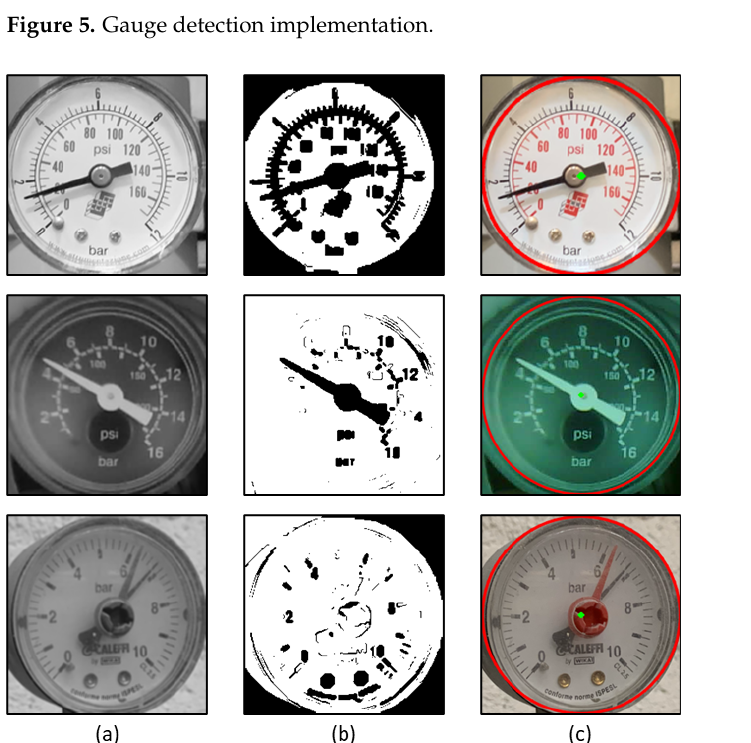
Figure 6. Dial gauge segmentation. ( a ) grayscale, RoI ( b ) region growing, ( c ) Hough